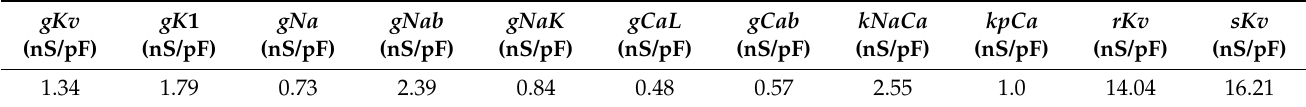
Table 2. Myofibroblast model parameters including ICaL with the intracellular Ca 2+ handling system ionic conductance